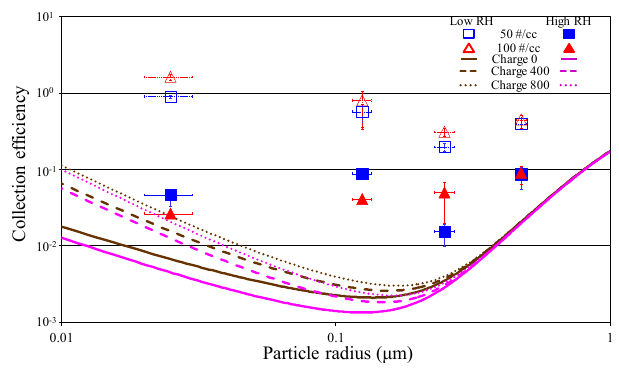
Figure 9. Comparison of CE experimentally determined in this study (points) with theoretical calculations (lines) where the charge number is elementary charge units per droplet (i.e., the lines span the range of measured droplet charge) and particles are singly